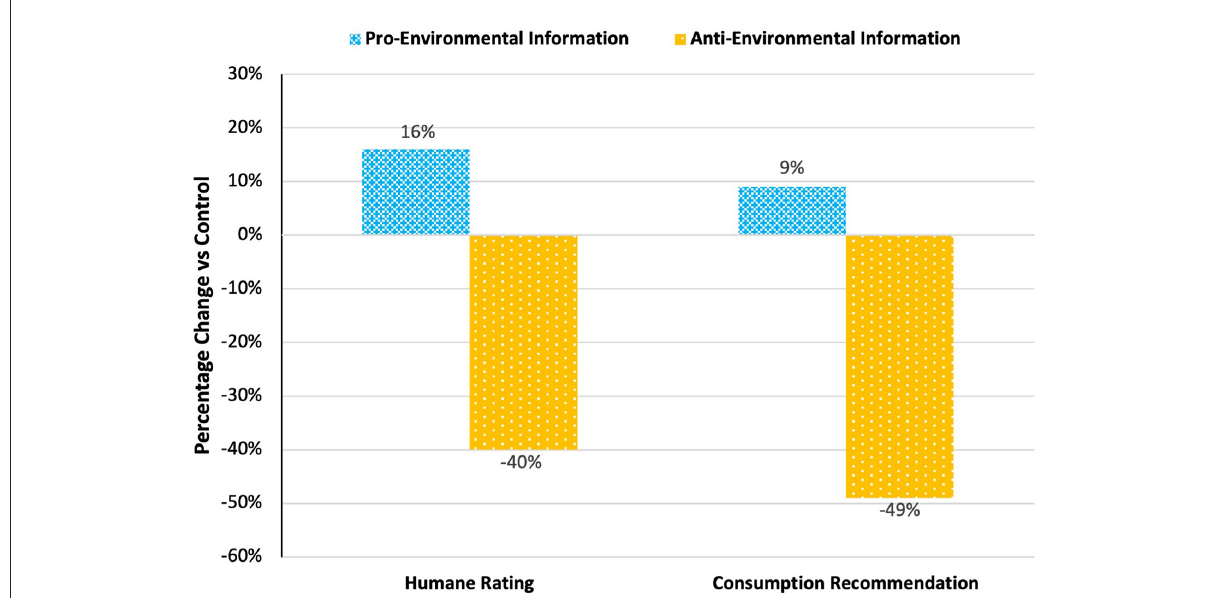
FIGURE5 Asymmetrical effect of positive (pro-environmental production practices) versus negative (anti-environmental production practices) information on participants’ perception of dairy cow treatment (humane rating) and their subsequent cheese consumption recommendation. The treatment effect of positive information ( versus a neutral control) is significantly smaller than the effect of negative information. In addition, when moving from the humane rating to the consumption decision, the effect of positive information is attenuated whereas the effect of negative information